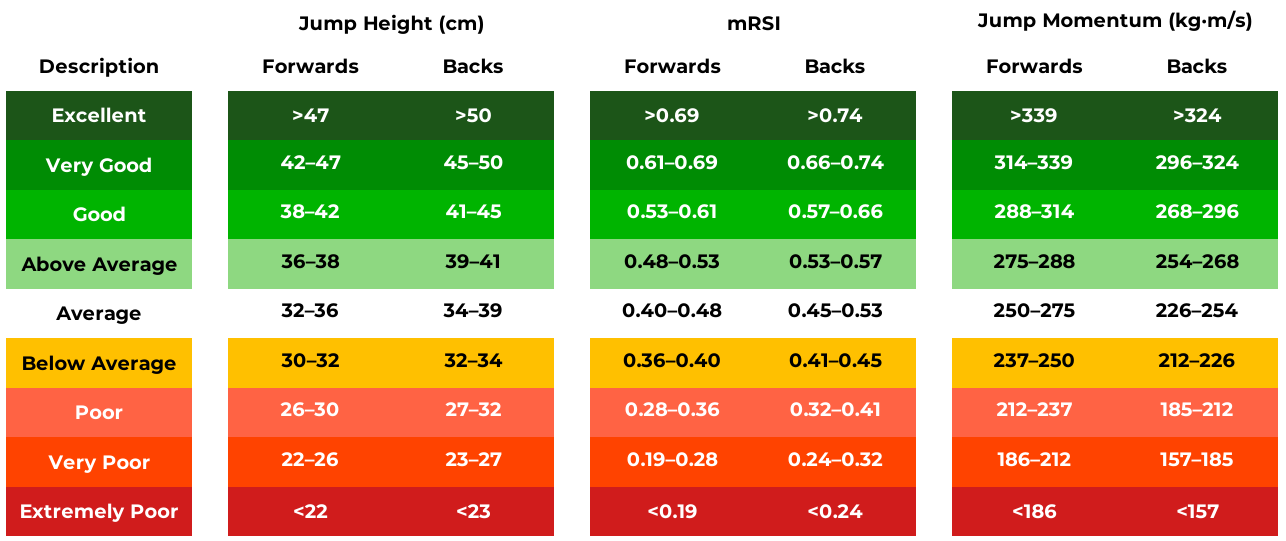
Figure 5. Countermovement jump normative data for rugby league forwards and backs with T-score bands and accompanying qualitative descriptions and traffic light system. mRSI = modified reactive strength index.